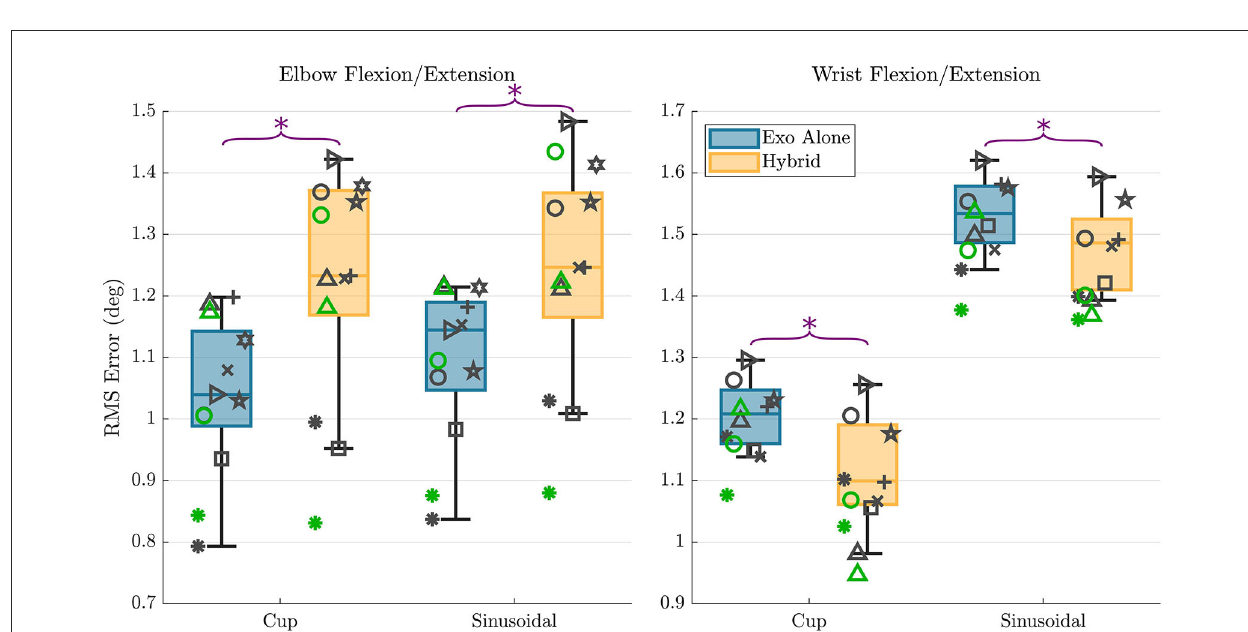
FIGURE7 RMS error results are shown for all subjects for each trajectory and each controller type for the elbow flexion/extension DOF (left) and wrist flexion/extension DOF (right) . The overlaid scatterplot shows individual subject results, with the same symbol representing a single subject across figures. Points in green show the repeated data collection for the first three subjects. The purple “ ∗ ” above the plots represents a that there was a statistically significant difference in the RMS errors between the two control types.